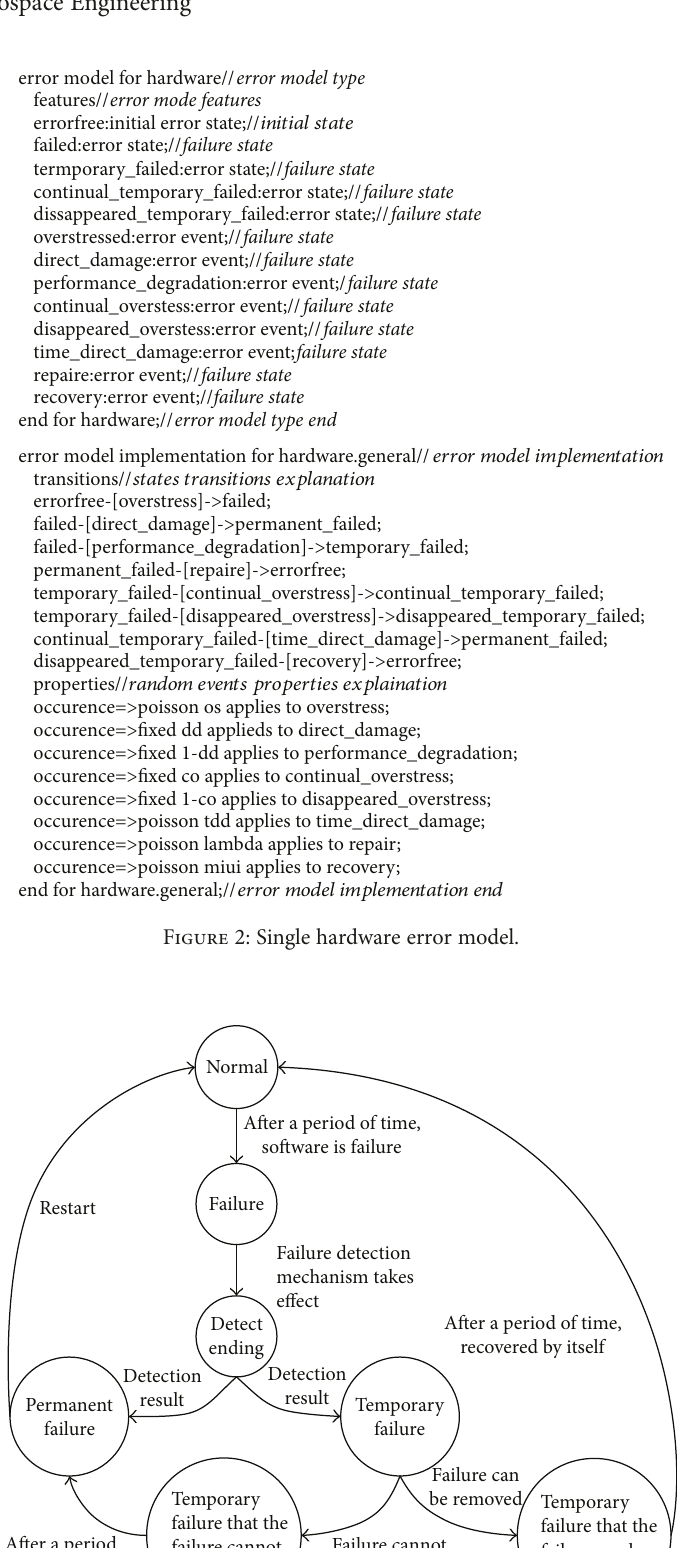
Figure 3: Transition behavior of IMA software error